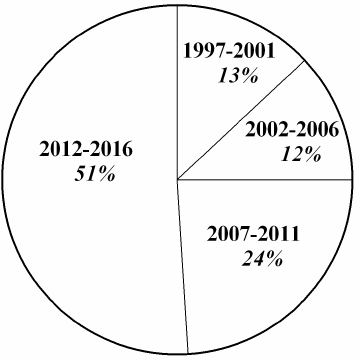
Figure 2. Initiation of home parenteral nutrition